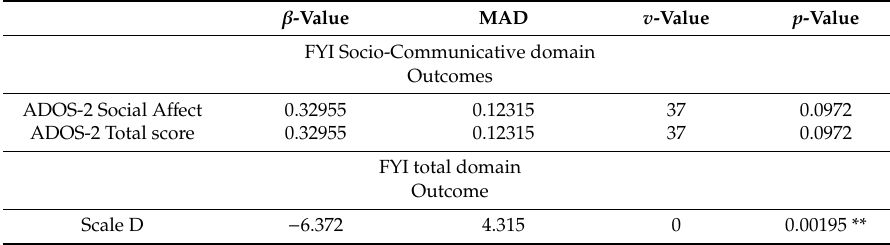
Table 7. Nonparametric regression between the FYI domain and the gold standard. β